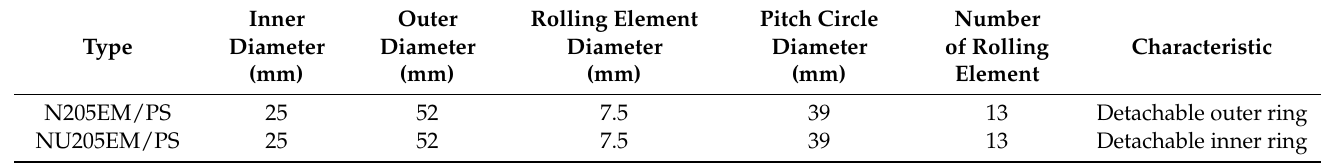
Table 4. The description of experimental data.